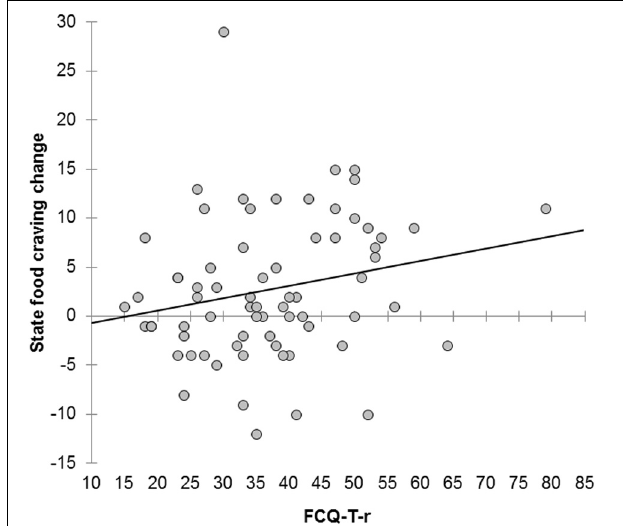
FIGURE 3 | Scatterplot showing the correlation between scores on the Food Cravings Questionnaire—Trait—reduced (FCQ-T-r) and increases in state food craving in study 2 ( r = 0 . 22, p = 0 . 07). Exclusion of the two outliers on the top and the right-hand corner did not essentially alter this correlation ( r = 0 . 24, p = 0 .